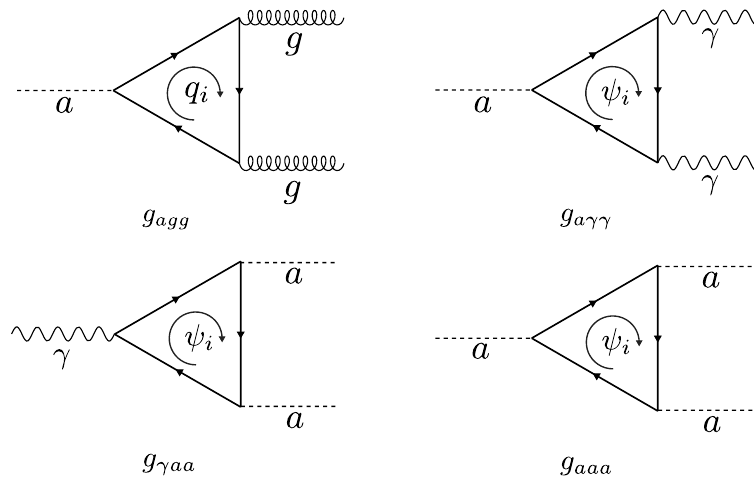
Figure 2 . Triangular diagrams associated with the axion in our model. Here a , (cid:13) , and g denote the axion, the photon, and the gluon, respectively, while i denotes all the fermions and q i the six quarks. The (cid:12)rst panel comes from the SU(3) 2 U(1) PQ anomaly and generates instanton e(cid:11)ects C (cid:2) implying CP conservation in the strong sector. The second panel comes from the U(1) 2 U(1) PQ EM (cid:2) anomaly and allows a decay of an axion into two photons and thus a detection possibility, suppressed by 1 =f a . The third and fourth panels depicts the vertices aa(cid:13) and aaa which are suppressed by 1 =f 2 and 1 =f 3 , a a